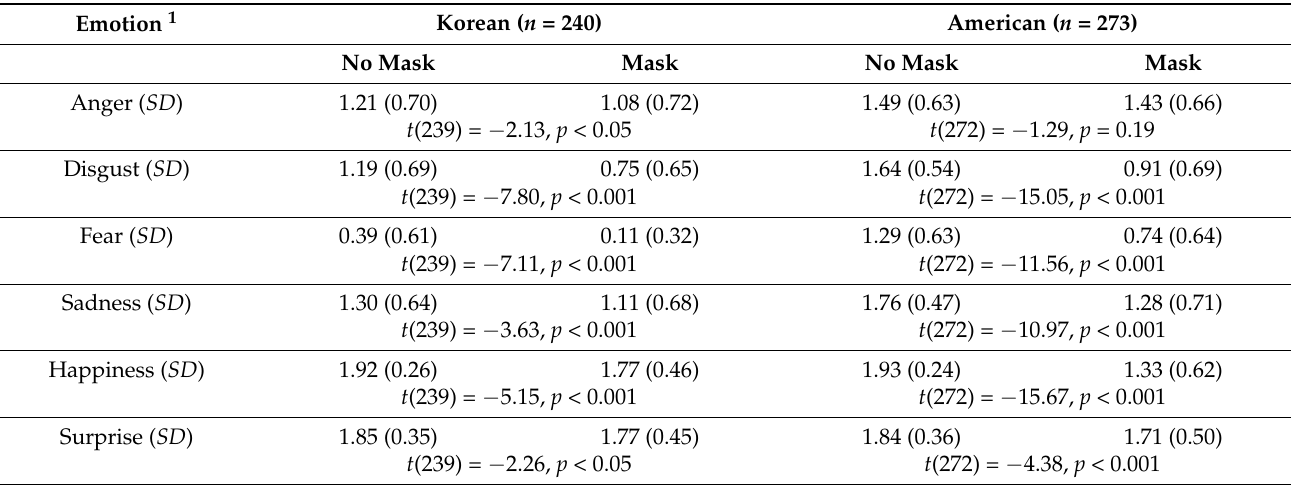
Table 4. Comparisons of participants’ accuracies to recognize senders’ facially expressed emotions between no mask and mask conditions for participant nationality groups.